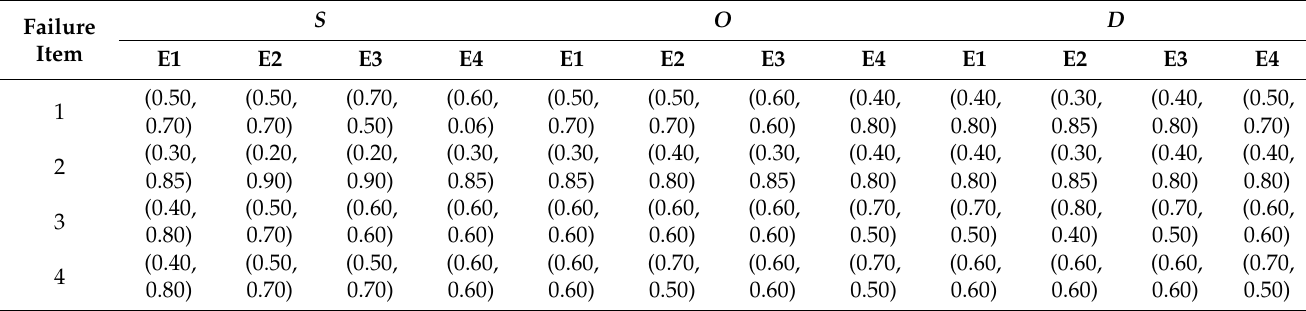
Table 5. The Fermatean fuzzy numbers of possible failure